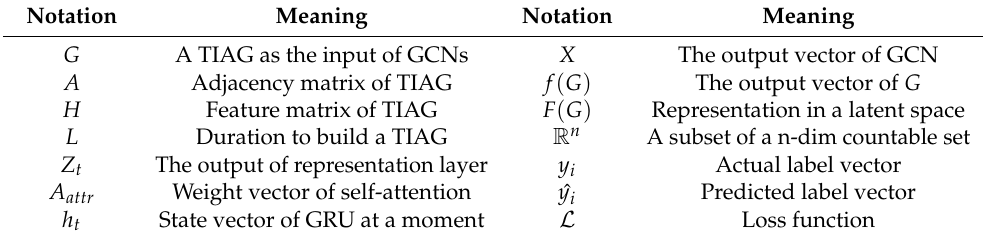
Table 4. List of